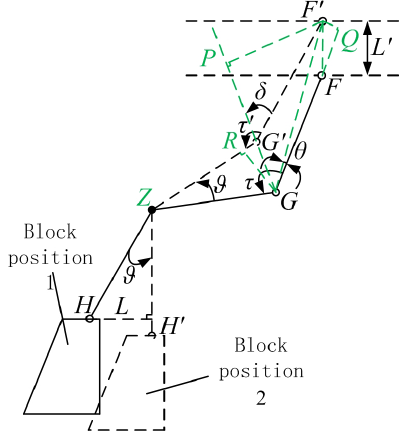
Figure 6. Closing motion model of the stopper in the process of manipulator